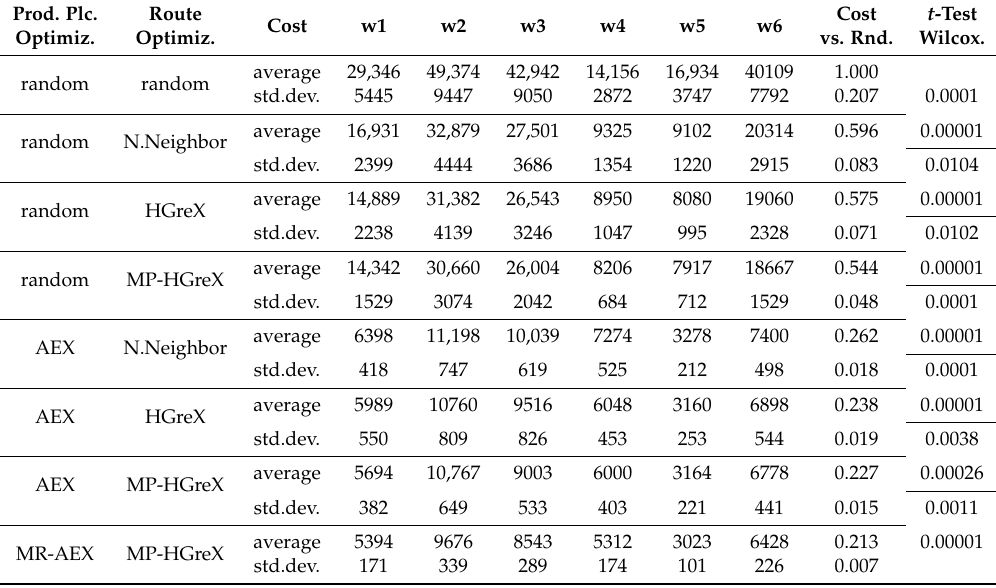
Table 4. The obtained product placement cost (the lower the better) as the sum of all order picking routes (see Equation (2)) for product placement and order picking route optimization methods with various improvements (see Section 5.4) for the six sample warehouses: w1, w2, w3, w4, w5, w6 with corresponding lists of orders, averaged over 10 optimization runs. The running times are presented in Table